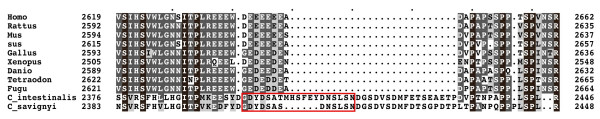
Amino acid alignment of the huntingtin region corresponding to exon 50–51 of Ciona. The red box indicates the region absent in the alternatively spliced isoform. Identical, similar and conserved positions are reported with different backgrounds.